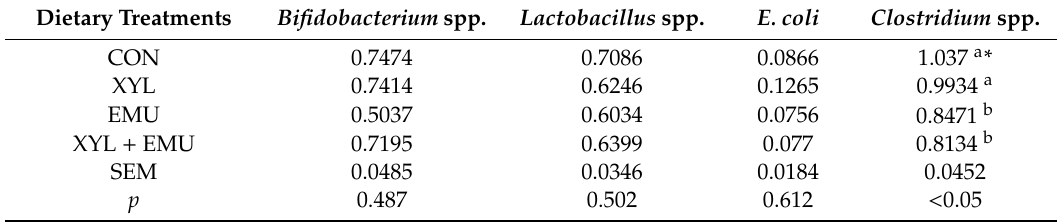
Table 8. Genera- and species-level bacterial populations from cecal contents measured on the 35th day of life in birds fed control (CON), control supplemented with xylanase (XYL), control supplemented with an emulsifier (EMU), and control diet supplemented with xylanase and emulsifier XYL + EMU. Dietary